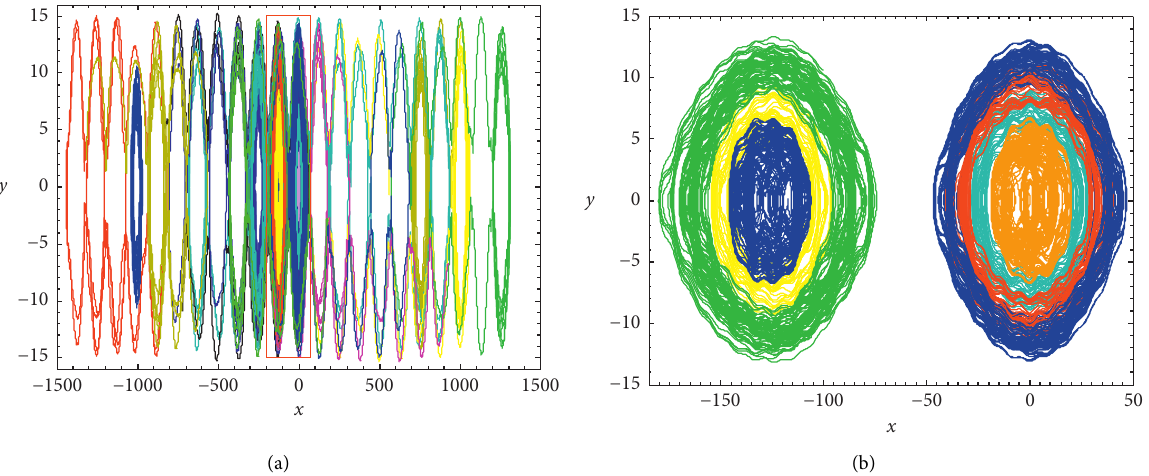
Figure 7: (a) Trajectories in system (28) for A � 1 . 2, with 75 initial conditions located on the x -axis (from x � − 150 to y � 150 with steps equal to 4). Each trajectory is plotted for 1200 seconds. (b) The enlarged version of the selected window in (a) (for interpretation of the references to color in this figure legend, the reader is referred to the web version of this article).